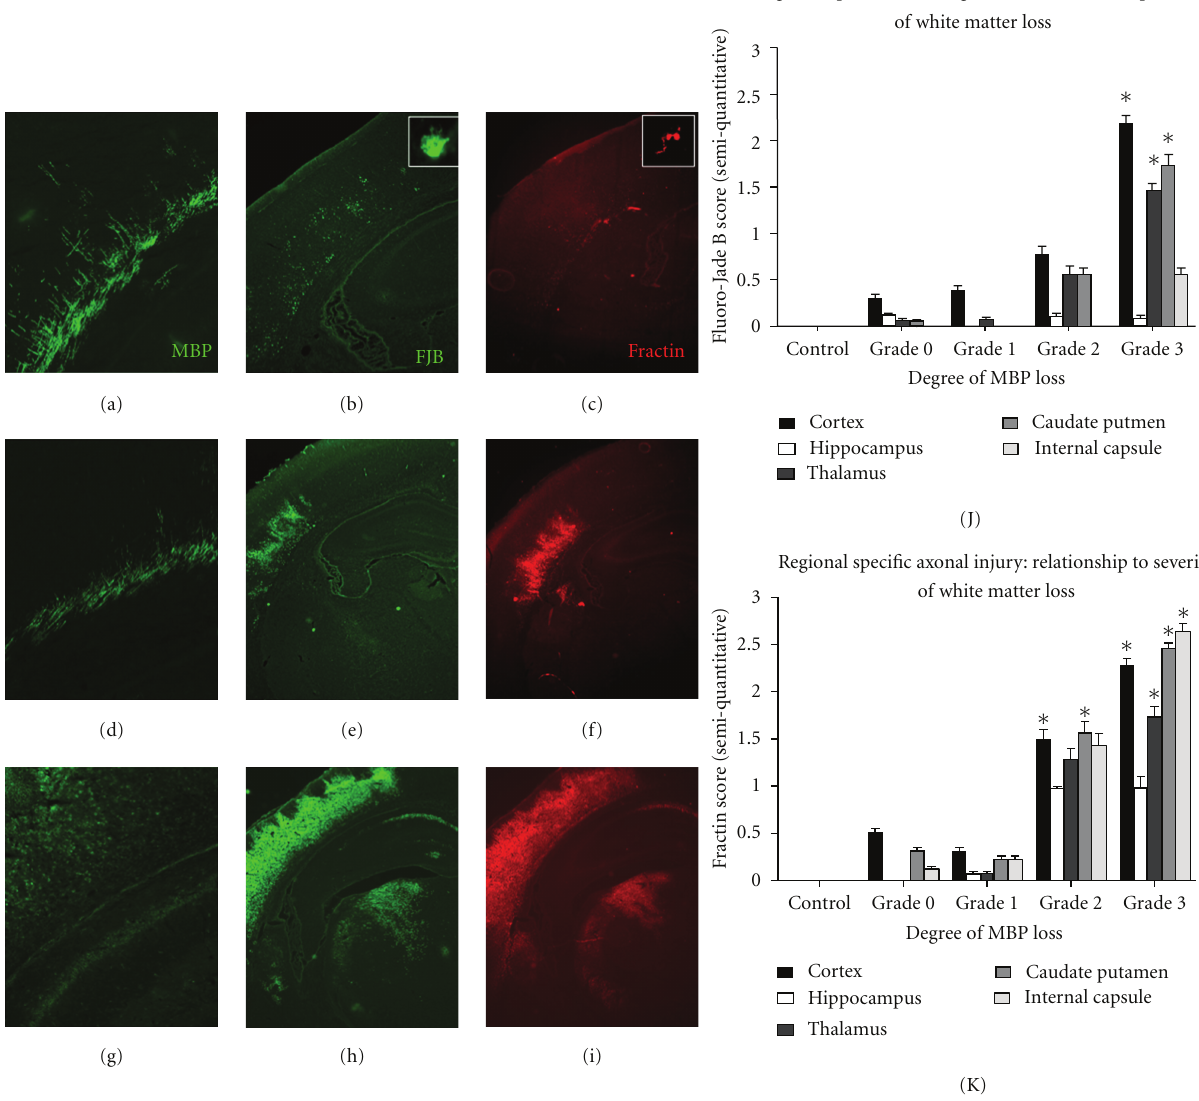
Figure 3: Significant grey matter injury accompanies myelin basic protein (MBP) loss in postnatal day 6 (P6) neonatal rats. Grey matter injury, as determined by neuronal and axonal degeneration, increases in hypoxic-ischemic neonatal rats with the severity of white matter injury. Representative photomicrographs show Grade 1 MBP loss (a), with mild cortical neuronal degeneration (FJB staining, (b)) and axonal injury (fractin immunoreactivity, (c)). With Grade 2 MBP loss (d), the density and distribution of FJB-positive neuronal cell bodies (e) and fractin-positive axons (f) increase in the cortex overlying the periventricular white matter. With Grade 3 MBP loss (g), the density of FJB-positive neuronal cell bodies (h) and fractin-positive spheroids (i) are further increased and encompasses the majority of the cortical mantle, as well as the hippocampus, thalamus, caudate putamen, and internal capsule. Histograms display region-specific neurodegeneration (j) and axonal injury (k) in relation to the severity of white matter loss. Magnification 100x for MBP and 25x for FJB and